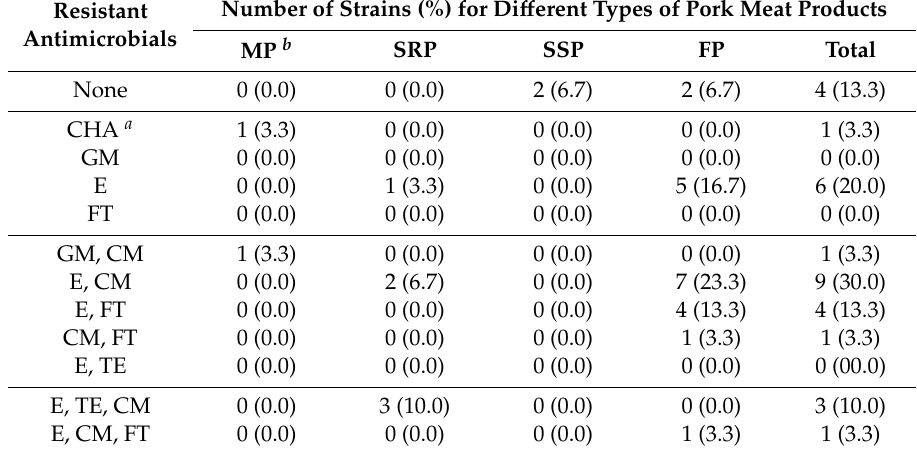
Table 3. Multidrug resistance of Enterococcus faecium isolated from processed pork meat products. Number of Strains (%) for Di ff erent Types of Pork Meat Products Resistant Antimicrobials MP